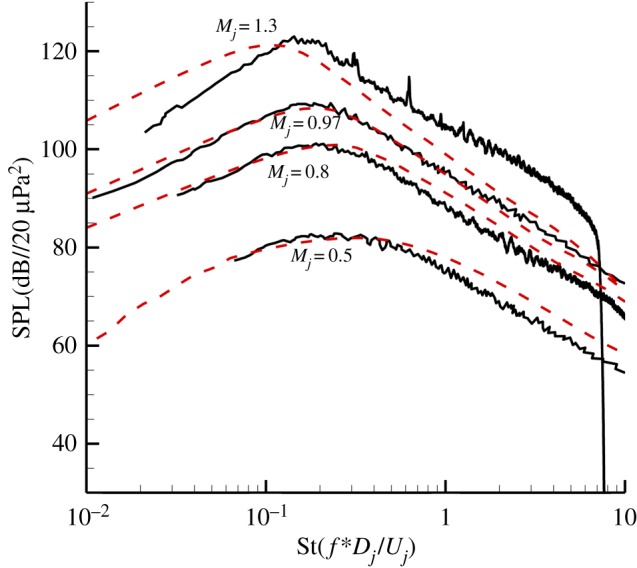
Comparison of spectra at 30° to the jet axis and R = 100D. (Online version in colour.)